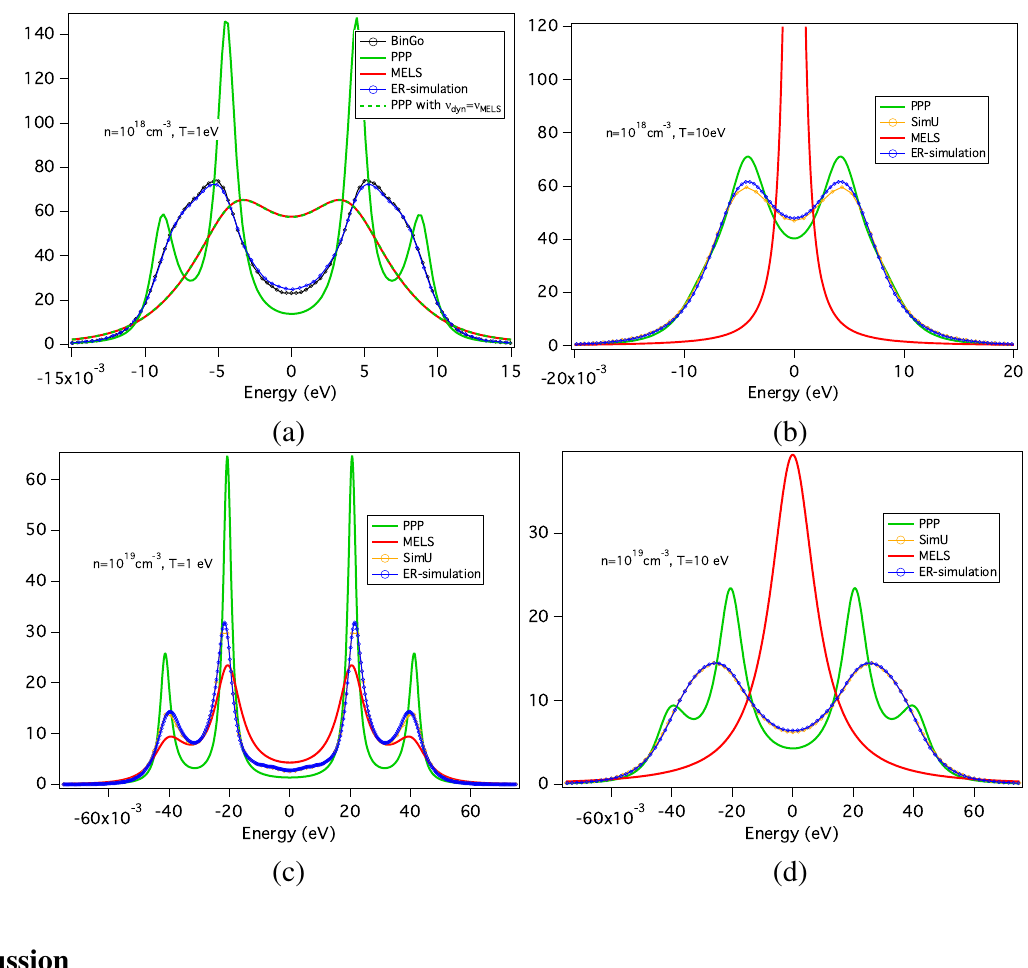
Figure 12. Spectral line shapes of the Lyman- β line in a pure rotating field. Comparisons of the results obtained by the different